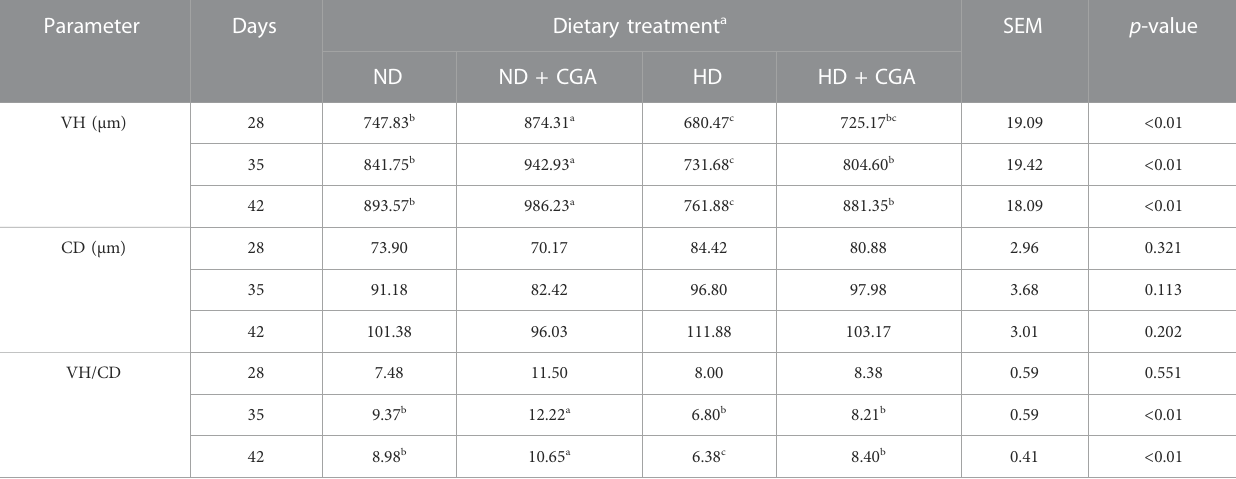
TABLE 3 Effects of CGA on Ileac morphology of Broilers under HD stress. Parameter